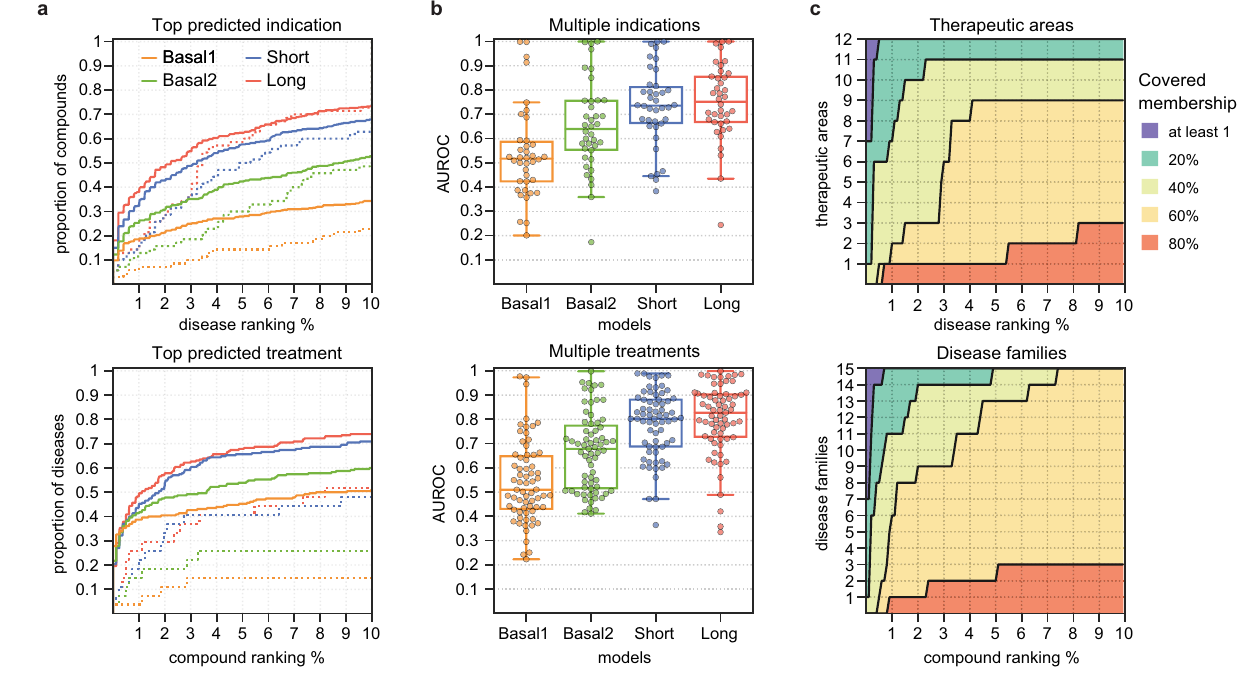
Fig. 7 | Prediction of drug indications and disease treatments from repoDB. a Cumulative distribution (y-axis) of compounds (top) and diseases (bottom) according to the ranked position (x-axis) of the top predicted disease indication (top) or compound treatment (bottom) for the four tested models. The rankings are shown in percentages and only for the fi rst 10% of compound/disease predic- tions (corresponding to the top 50 and 80diseases and compounds, respectively). Dotted lines show the distribution for those compounds or diseases with only one positive indication in repoDB v1. b Classi fi cation performance obtained for each